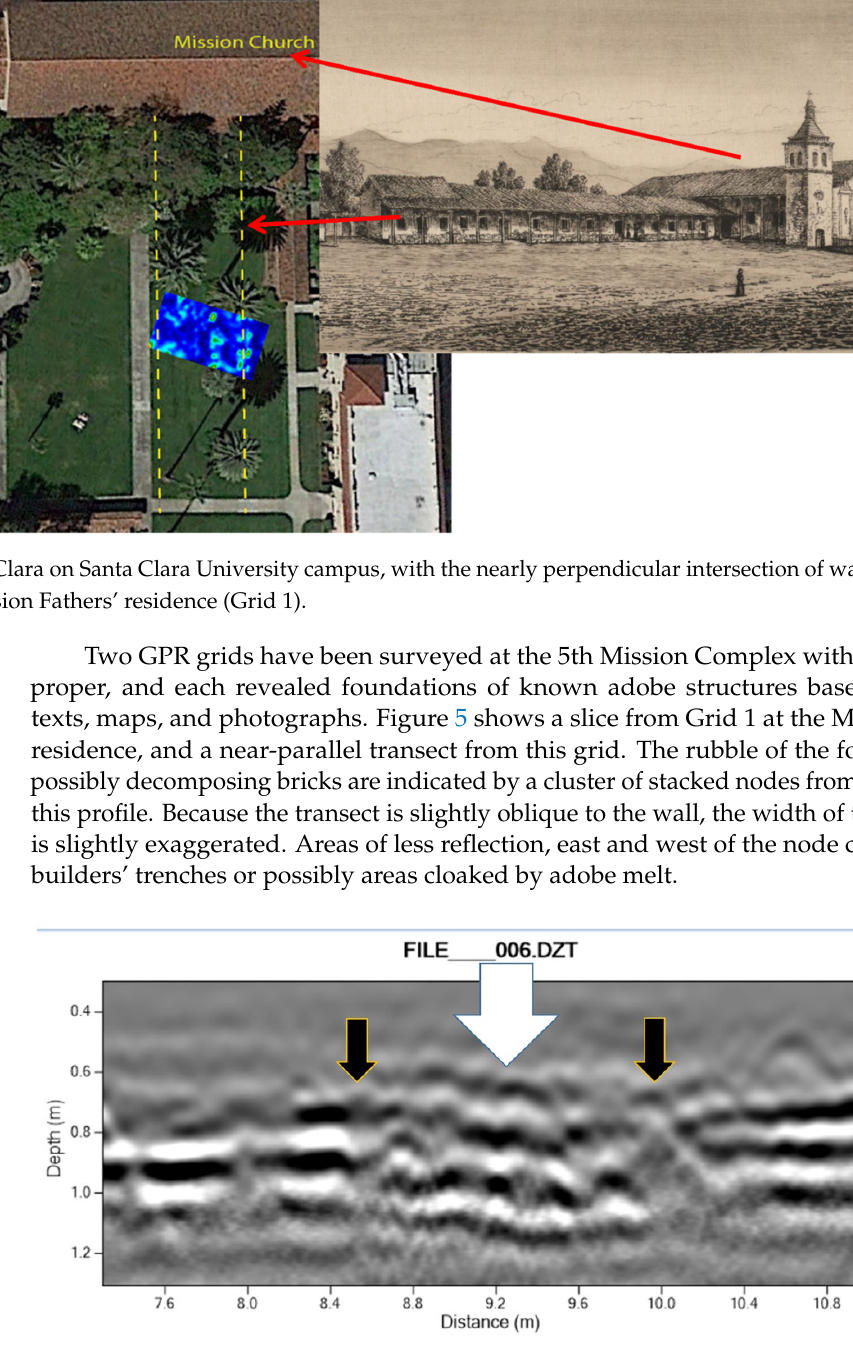
Figure 5. Possible builders’ trenches on both sides of the east wall (thick white arrow) at Mission Santa Clara seen as gaps (thinner black arrows) in horizontal strata to left and right in transect using the 400 MHz